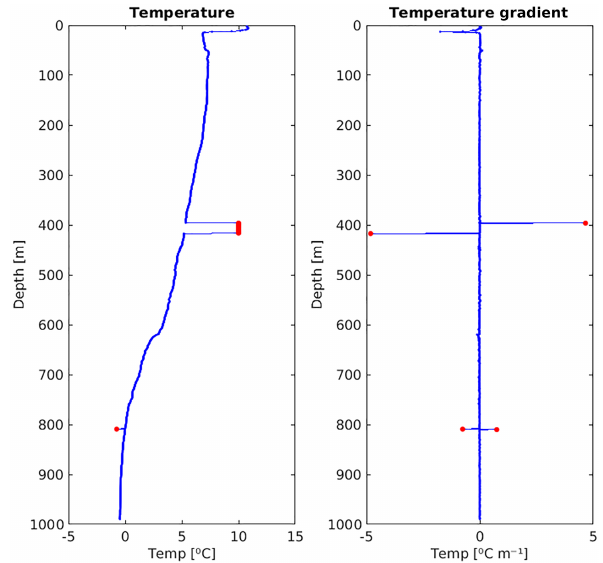
Figure 5. CTD temperature profile measured on 13 July 1998 near the Lofoten Islands. Source: ices. Ship: Johan Hjort. Station: 434. Two outliers (red dots) were detected at around 400m depth (artifi- cially induced) and 800m depth (real). See Sect. 3 for a description of the detection